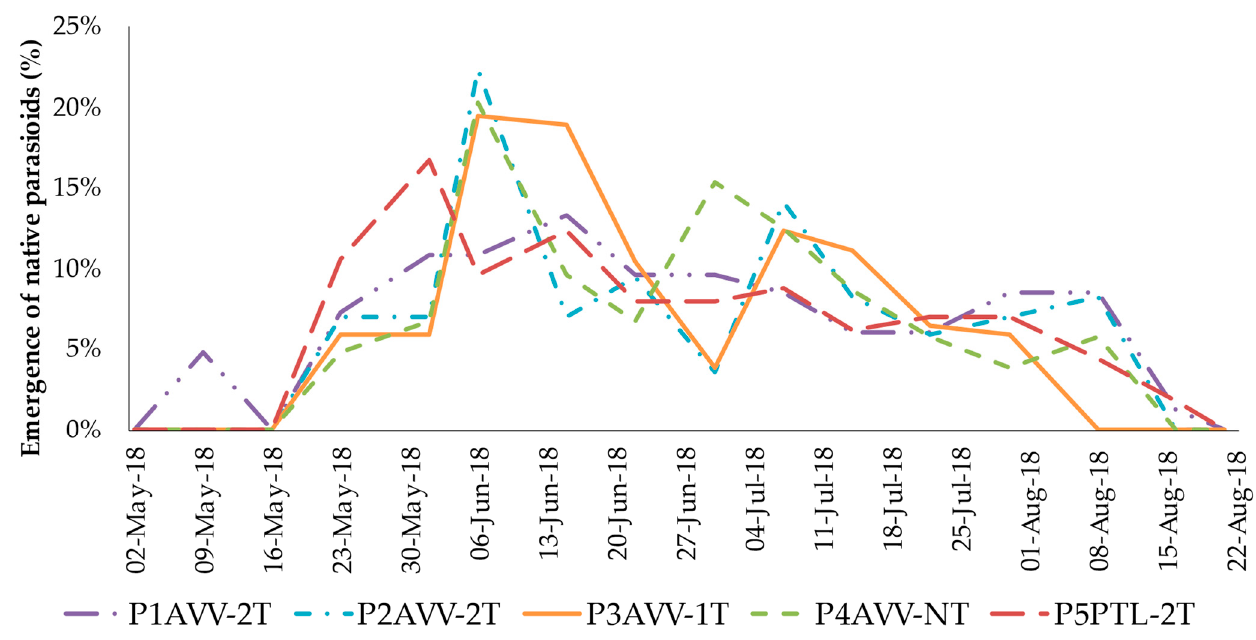
Figure 7. Weekly evolution of the emergence of native D. kuriphilus parasitoids in five chestnut orchards (P1 to P5) located in Arcos de Valdevez (AVV) and Ponte de Lima (PTL), with one (1T), two (2T) or no treatment (NT) from T. sinensis in 2018.